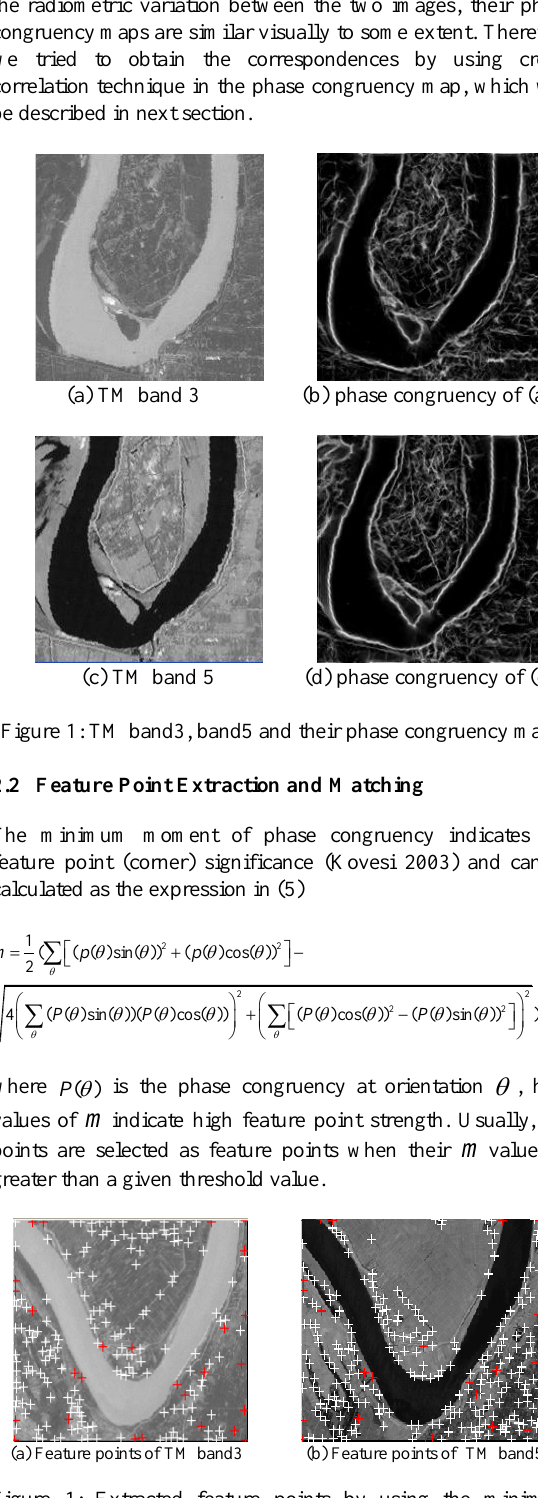
Figure 1: Extracted feature points by using the minimum moment of phase